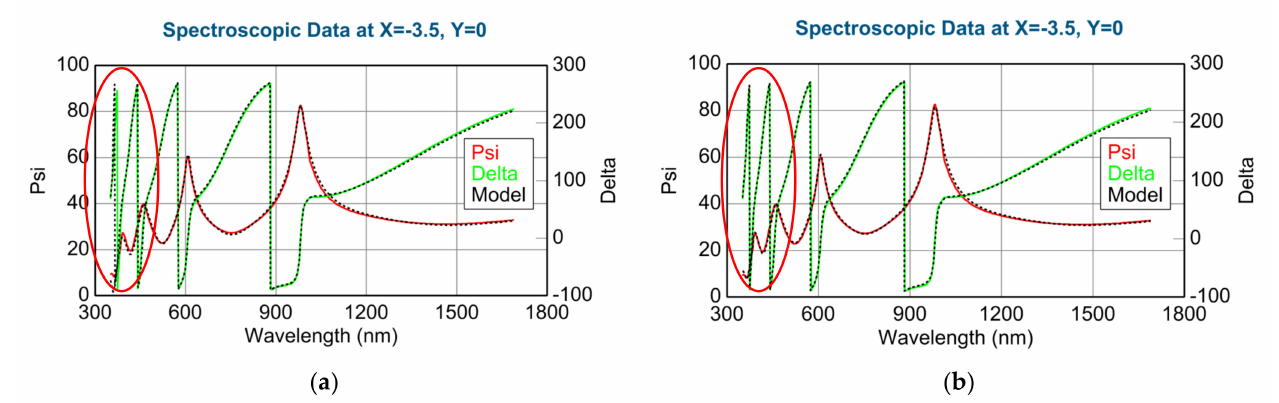
Figure 4. Measured (continuous lines) and fitted (dotted lines) SE spectra for the 100% WO 3 layer composition using Cauchy ( a ) and Tauc-Lorentz (T-L) ( b ) formulas. Red ellipses show the region where the quality of the fit is different, and is better using the Tauc-Lorentz